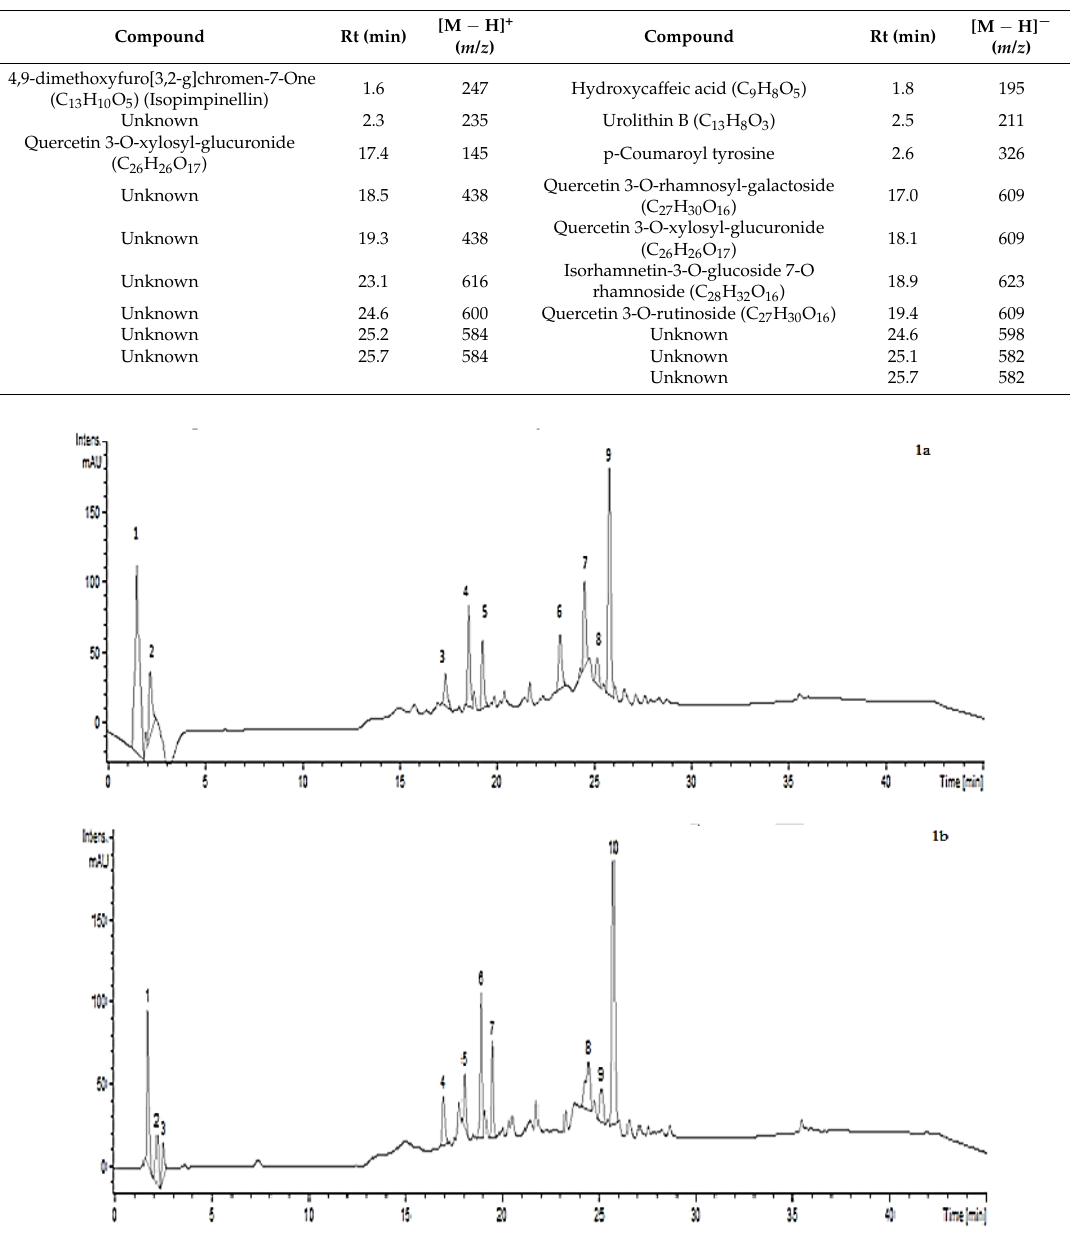
Table 1. Phenolic compounds identified in the ethanolic extract of bee pollen from the region of Epirus using HPLC/ESI-MS [MS mode: ( ± ). Rt: retention time. λ max : 254 ± 2 nm].